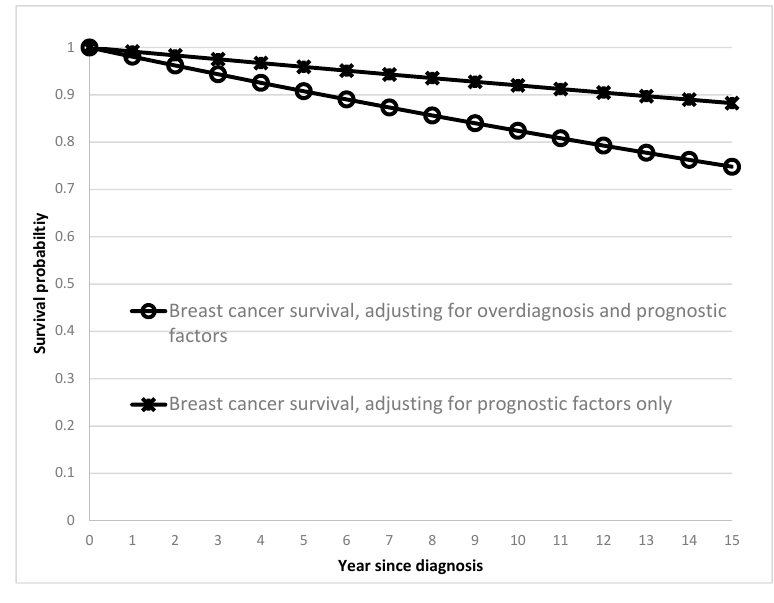
Figure 2. Cumulative survival of breast cancer-based models with and without considering overdiagnosis.